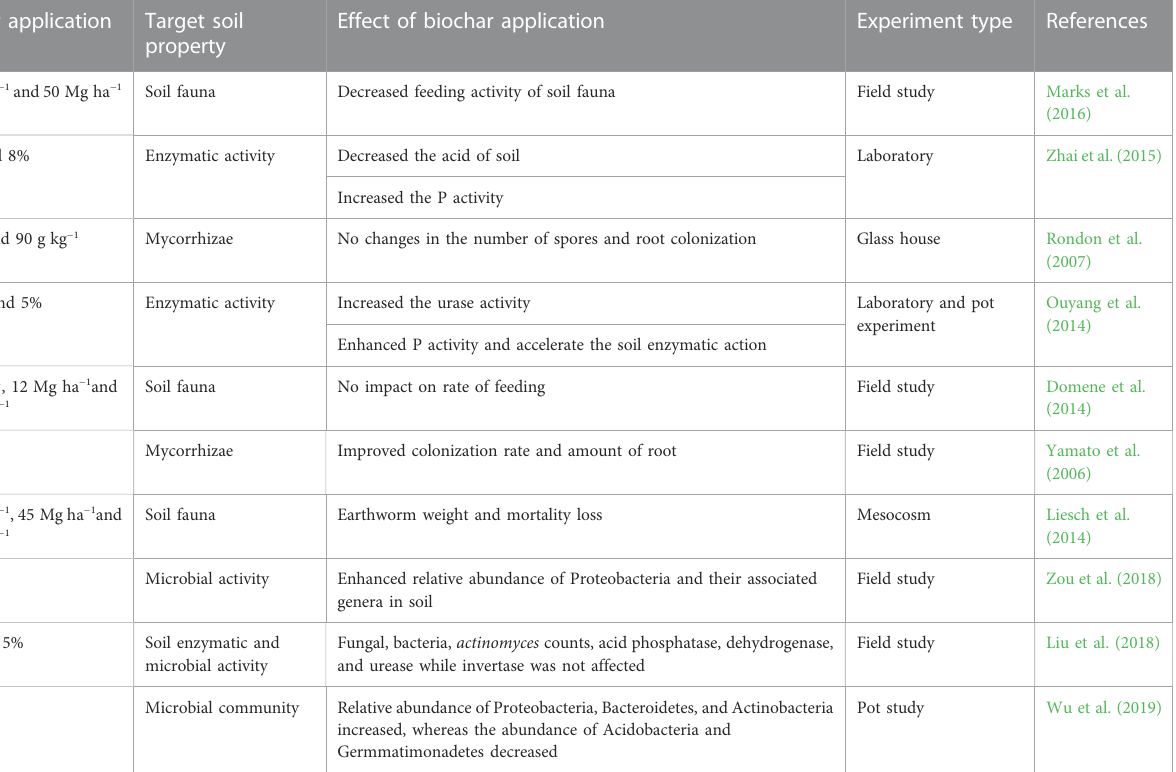
TABLE 3 Effects of biochar addition on soil biological